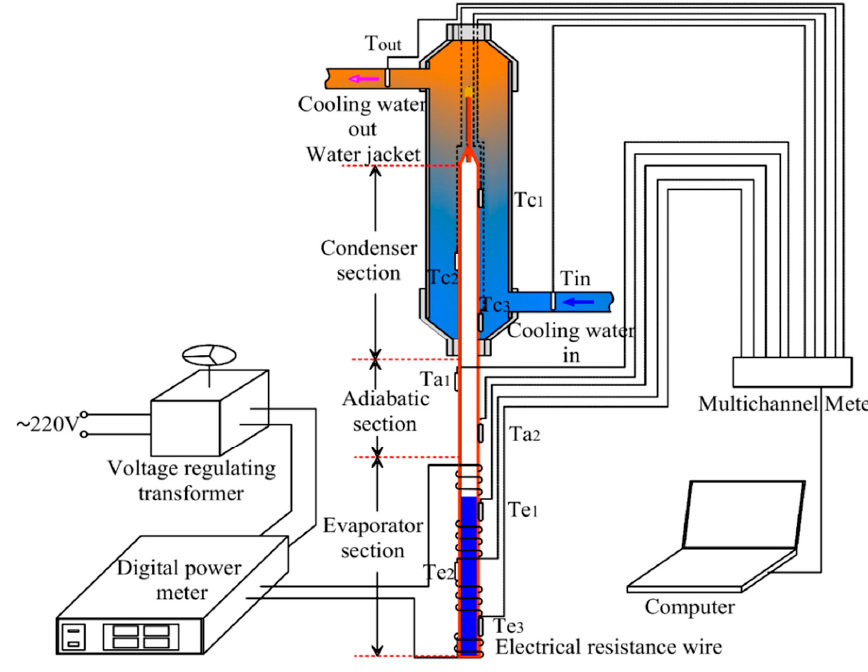
Table 1. The boundary conditions of the experiment.